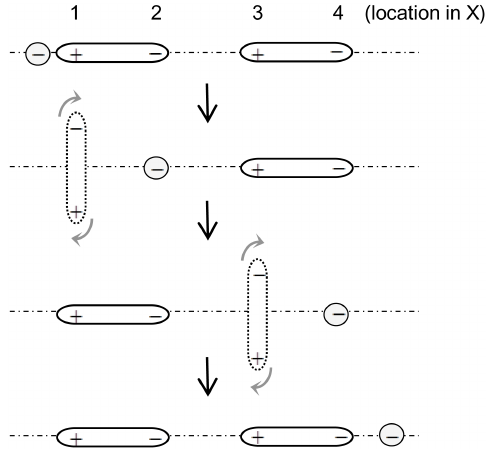
Fig. 3. Electric current and